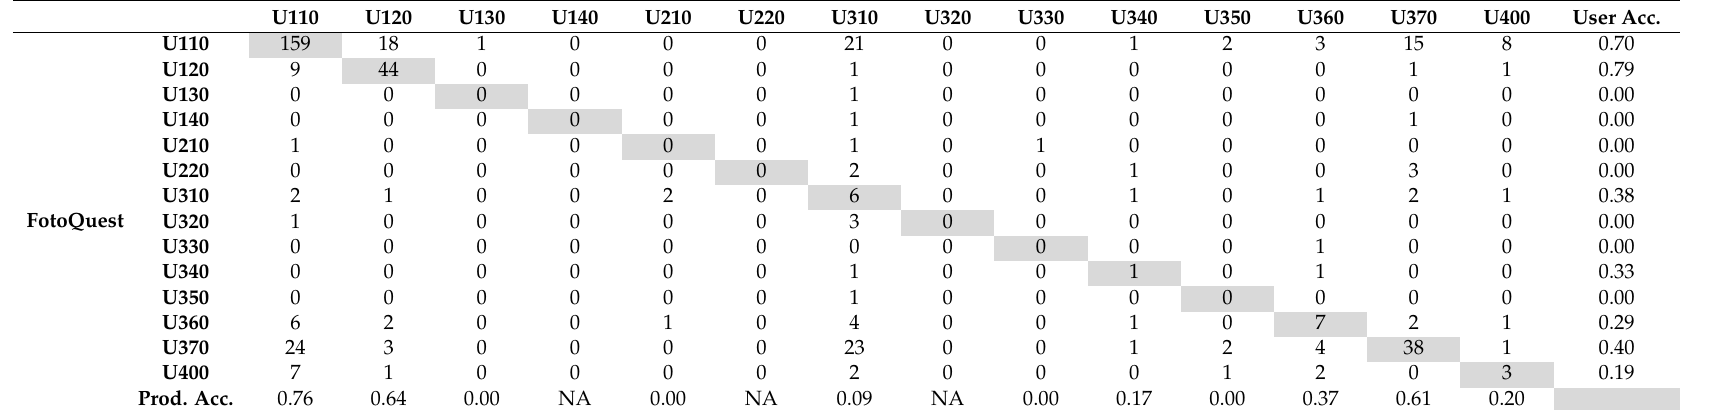
Table 5. Confusion matrix showing level 1 land use classifications from FotoQuest and LUCAS